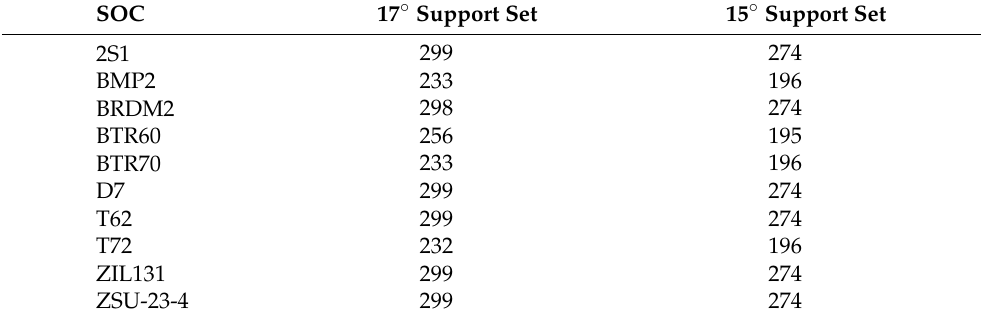
Table 1. Categories among MSTAR SOC.